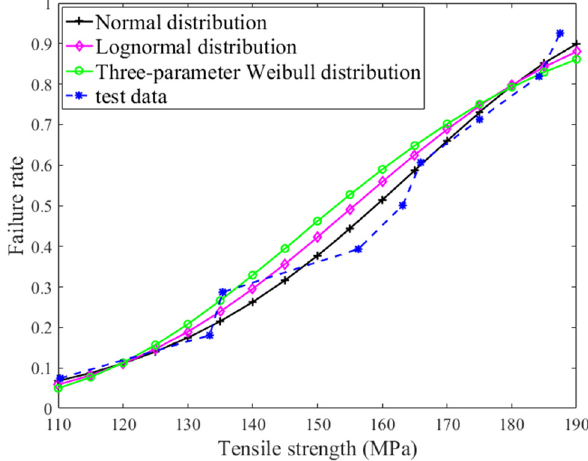
Figure 2: Fitting results of failure rate distribution of the tensile